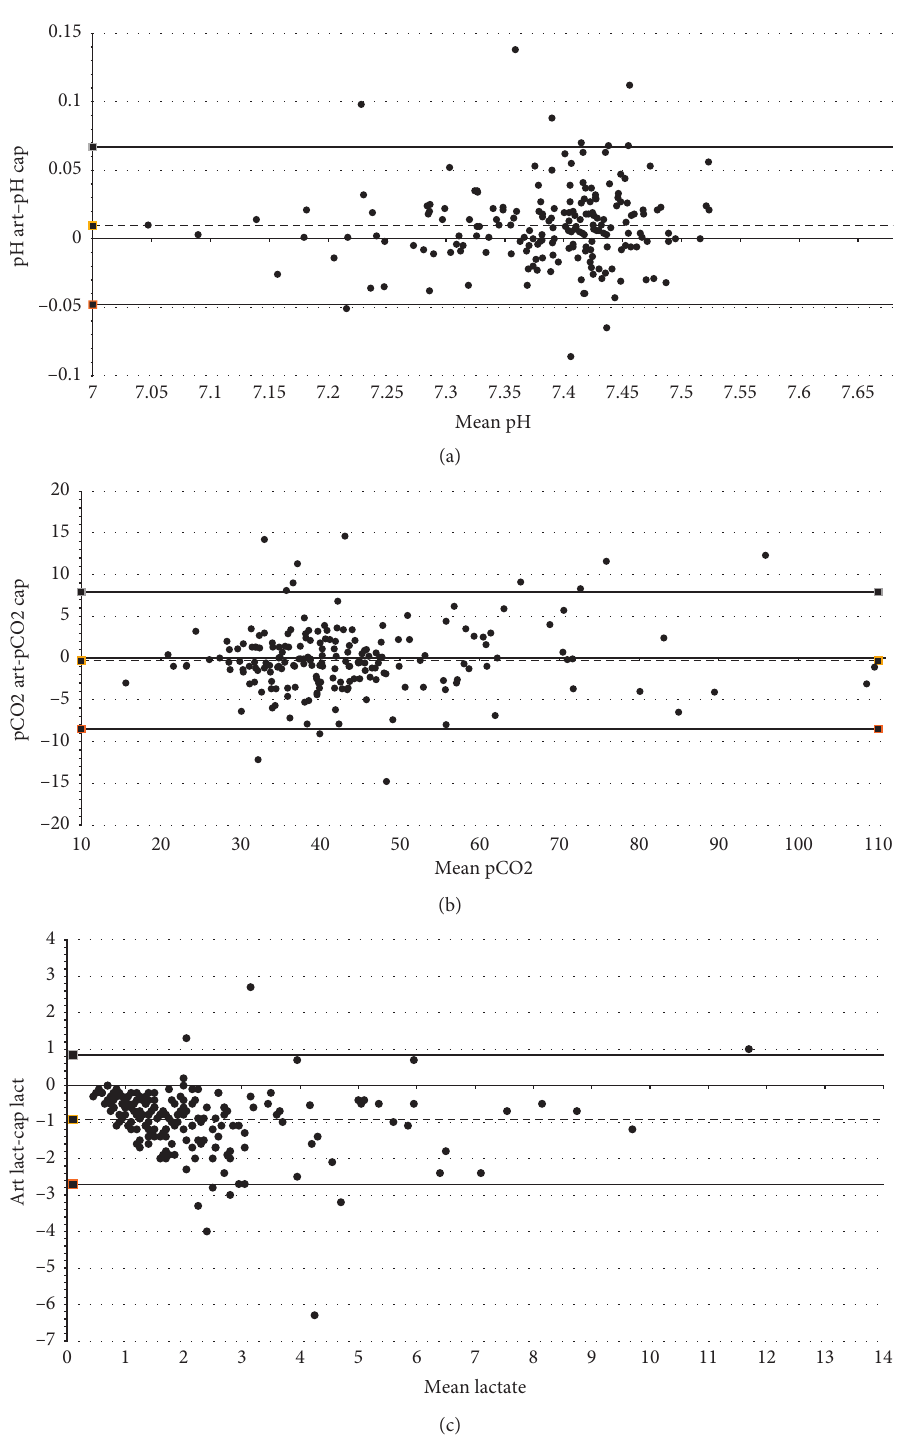
Figure 2: Bland-Altman agreement plots for paired measures of pH, pCO 2 , and lactate. (a) Bland-Altman arterial pH-capillary pH. (b) Bland-Altman arterial pCO 2 -capillary pCO 2 . (c) Bland-Altman arterial lact-capillary lact. (a) The bias was 0.01 (95% limits of agreement − 0.048–0.067) for paired capillary and arterial measures of pH. (b) The bias was − 0.3 (95% limits of agreement, − 8.5–7.9 mmHg) for paired measures of pCO 2 . (c) The bias was − 0.93 (95% limits of agreement − 2.7–0.84mmol/L) for paired measures of